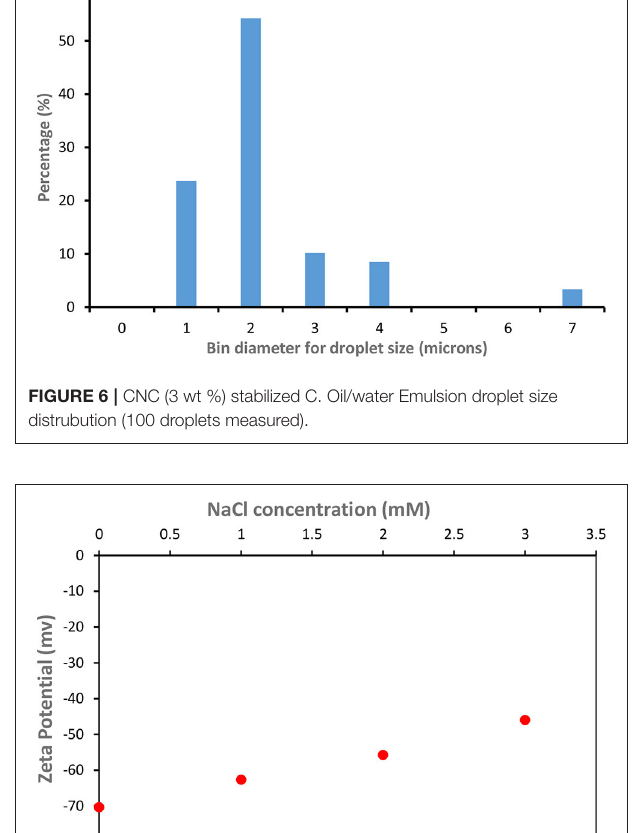
(Figure 3a) and from 1 to 5 wt% (Figure 3b). The oil and aqueous layers separated clearly. At CNC concentrations of 1 and 2 wt%, a stable emulsion is formed between the oil and the aqueous layers where the emulsion volume is lower than the initial oil volume.